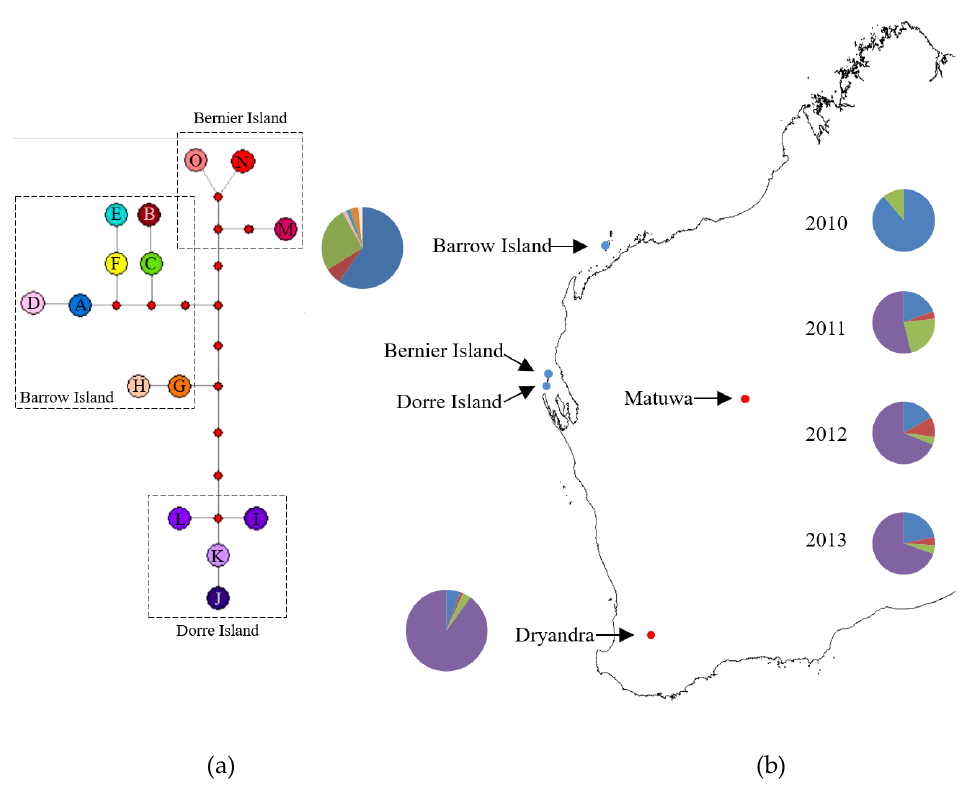
Figure 2. Haplotype network of Bettongia lesueur island populations and present distribution of B. lesueur . ( a ) Haplotype Network of 15 unique haplotypes detected in D-loop region of mitochondrial DNA. Boxes represent island populations. Each circle represents one haplotype with haplotype ID in the circle. Red dots and lines represent unsampled ancestral haplotypes and mutation steps, respectively. ( b ) Blue dots represent the locations of remaining natural populations (Barrow, Bernier, and Dorre Islands). Red dots are two translocated populations (Dryandra and Matuwa). Pie charts on the left represent haplotype frequencies in Barrow Island and Dryandra individuals used to establish the Matuwa translocated population. Pie charts on the right represent haplotype frequencies in samples taken from the Matuwa population between 2010 and 2013. Colours in pie charts represent haplotypes identified in ( a ).